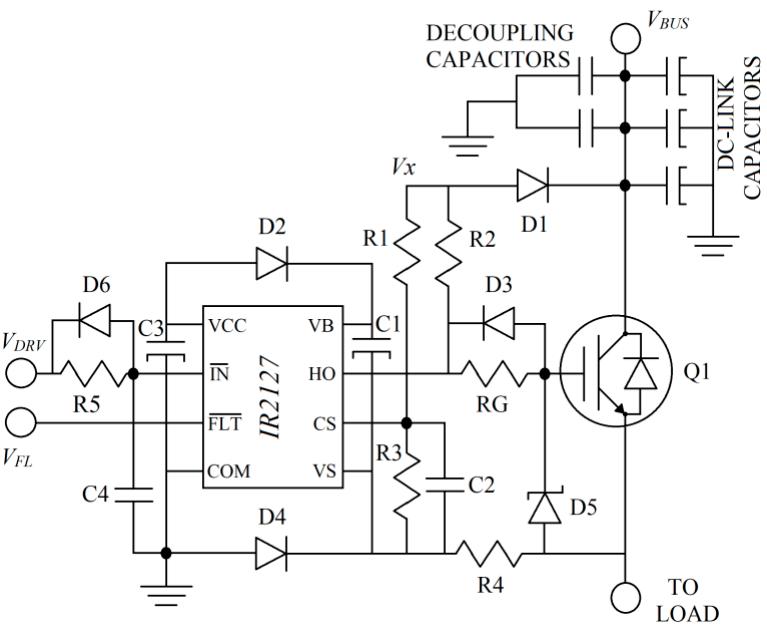
Figure 6. Short-circuit current diagnostic topology based on the IR2127STRPBF integrated circuit. The figure shows the high-side driver solely.